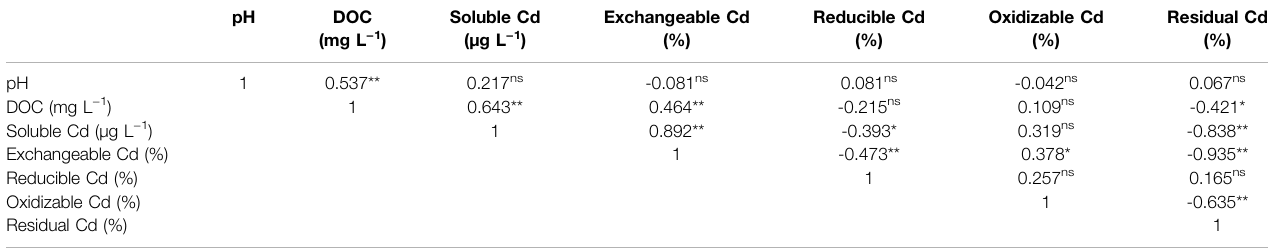
TABLE 1 | Correlations between pH, DOC, and soluble Cd concentrations in soil leachate and Cd speciation in remaining